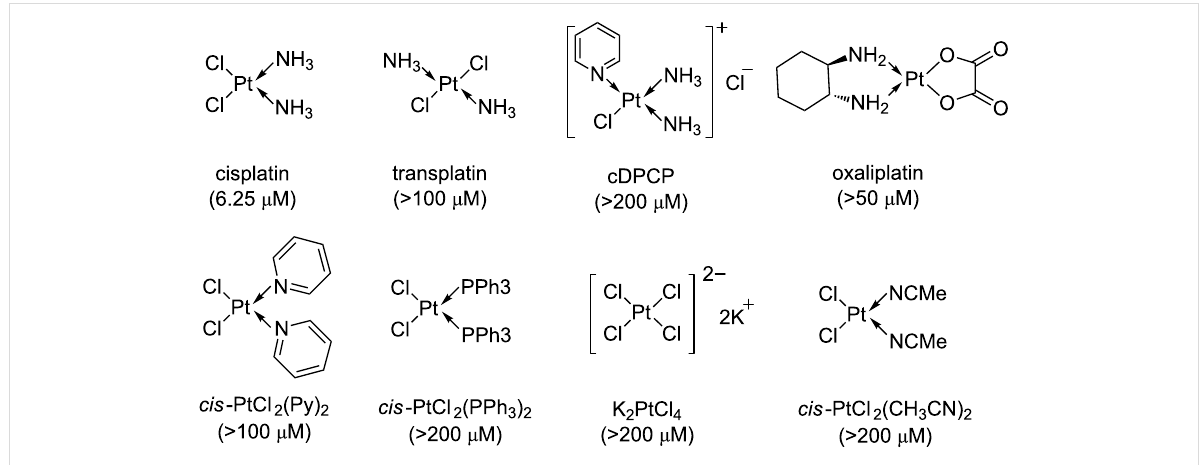
Figure 1: Structures and MICs of Pt-based compounds against P. aeruginosa PAO1.